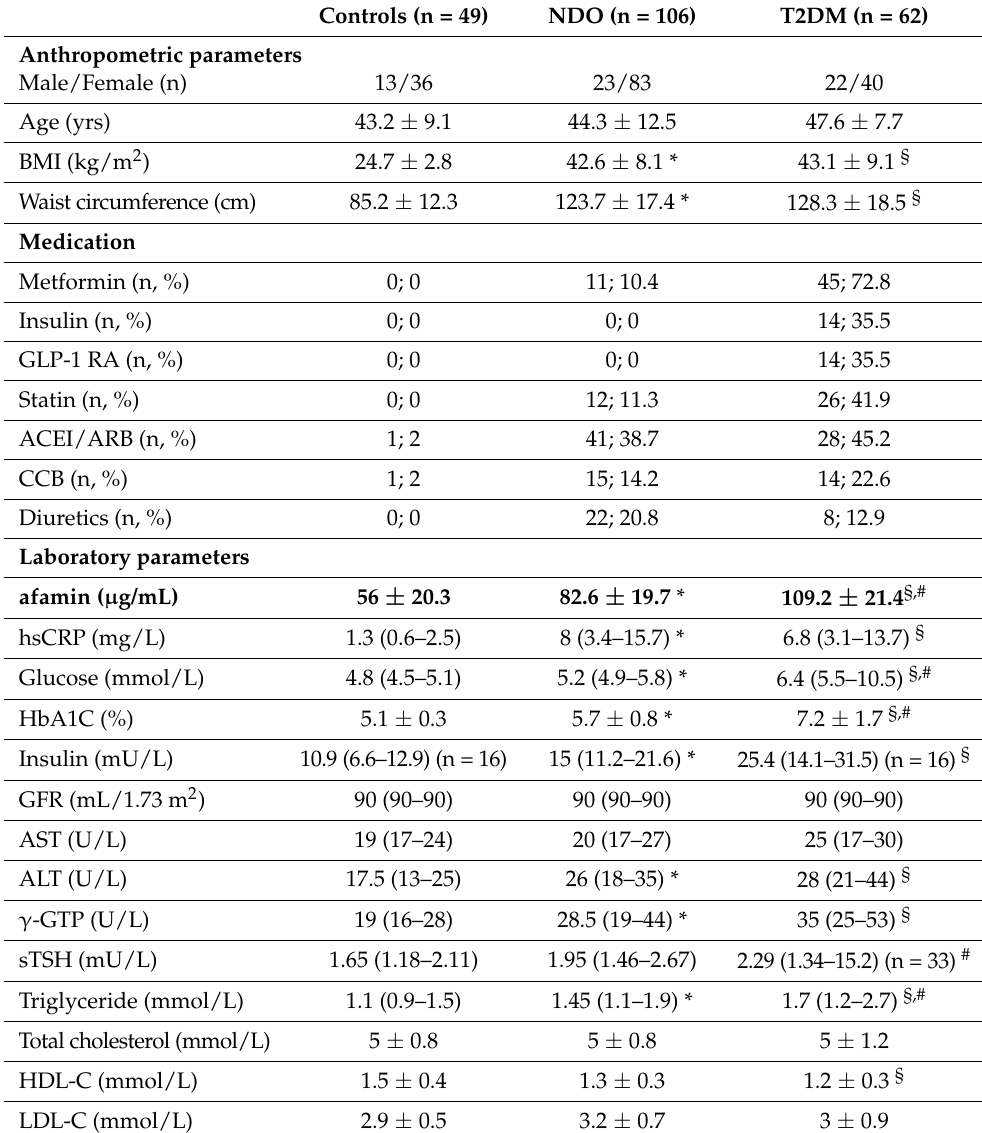
Table 1. Anthropometric data, laboratory parameters, and main medications of study